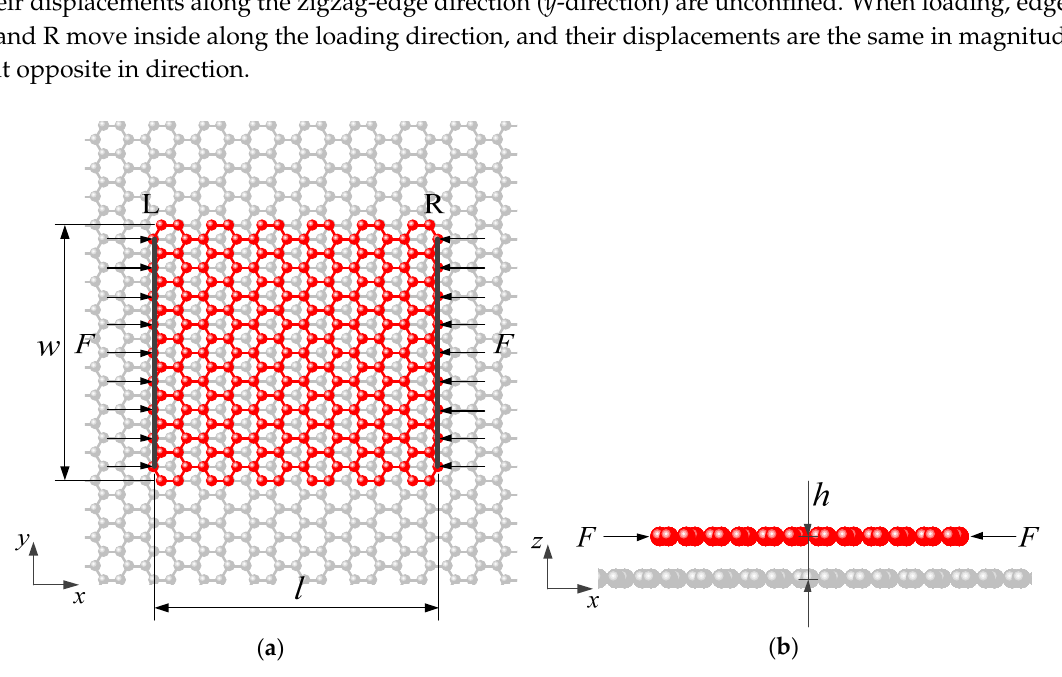
Figure 1. Sketch of a graphene sheet subjected to the compressive force F on an infinite large graphene substrate: ( a ) top view; and ( b ) side view.